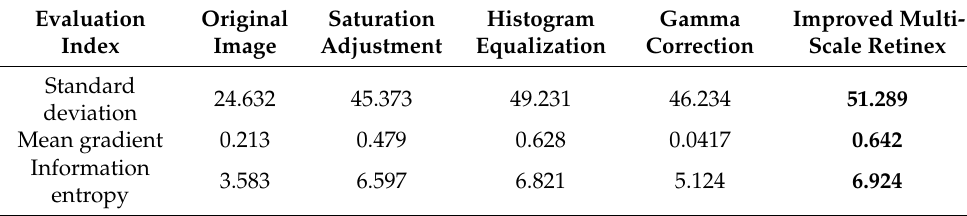
Table 3. Comparison of image quality between before and after image